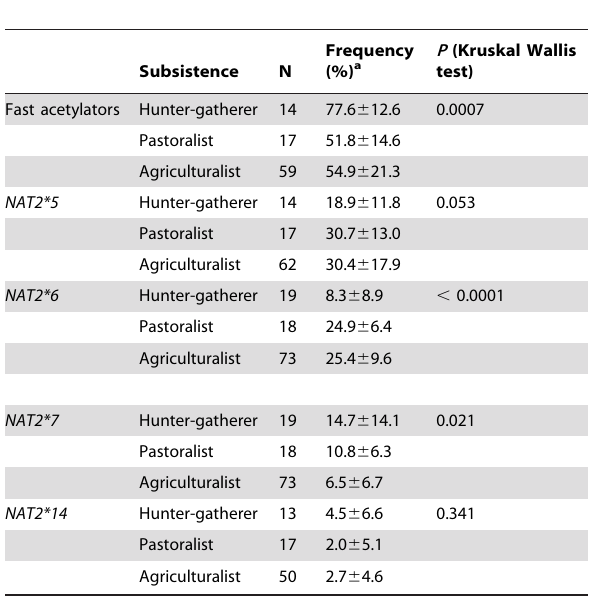
Table 1. Test for equality of frequency of phenotype and haplotype series across subsistence